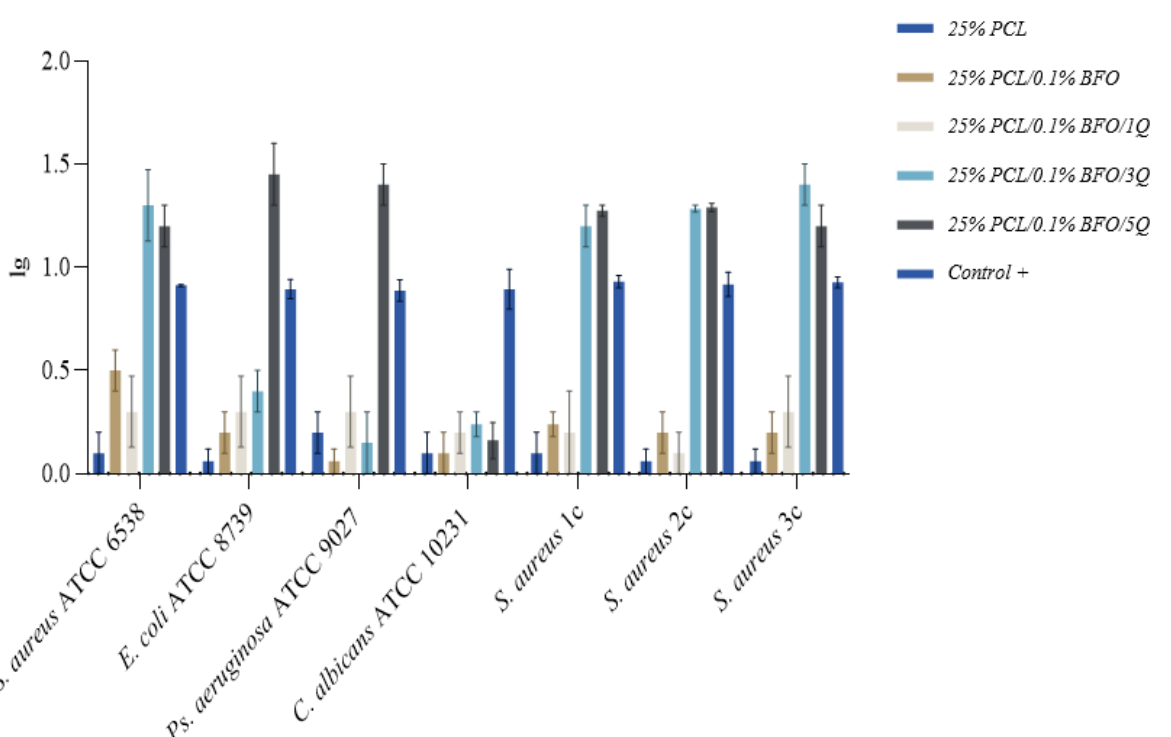
Figure 8. Depiction of summary of antimicrobial efficacy expressed as CFU/mL reduction for microfibrous scaffolds, as CFU/mL reduction. Positive control = 5 mg/mL Q solution.